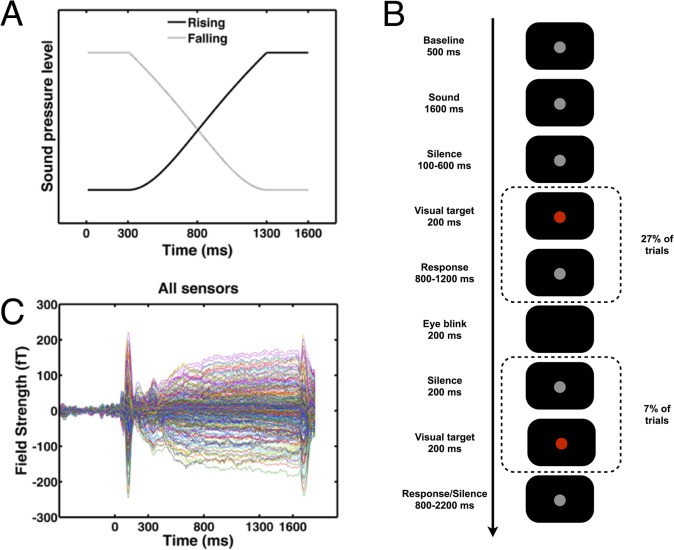
Experimental procedures.A: Illustration of the sound stimuli used in this experiment. After an initial constant sound pressure level [SPL] segment of 300 ms, SPL rises (or falls) over 1000 ms; the sound terminates with another segment of constant SPL. B: Intra-trial procedure. Our analysis focuses on responses to the sound. Participants were instructed to blink only in designated periods between sounds. A visual task was introduced between sound presentations to increase alertness and render the eye blink task plausible to the participant. C: Global sound responses to all sound stimuli, for all sensors. The intensity change segment of the sound was between 300 and 1300 ms.